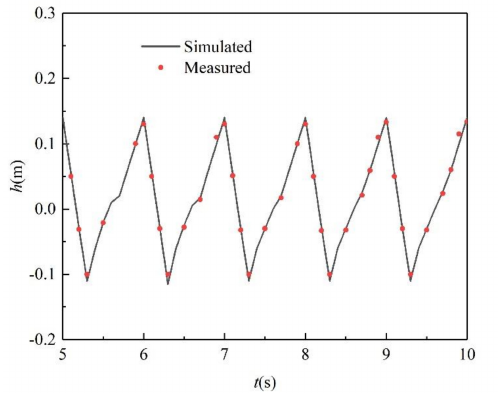
Figure 5. Validation of free surface elevation against experiment